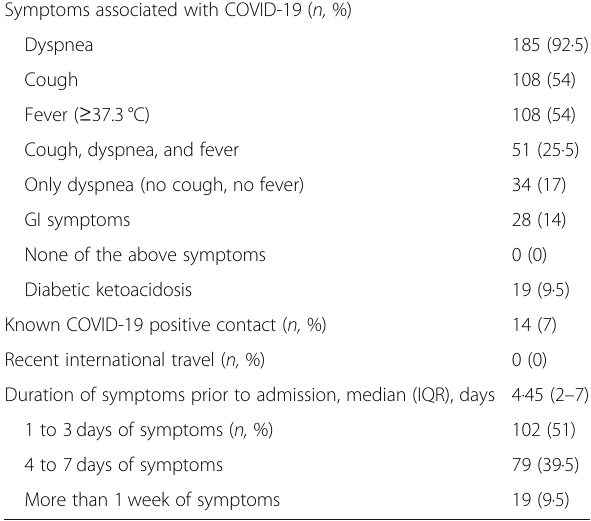
Table 2 Admission characteristics, n = 200 patients Symptoms associated with COVID-19 ( n,